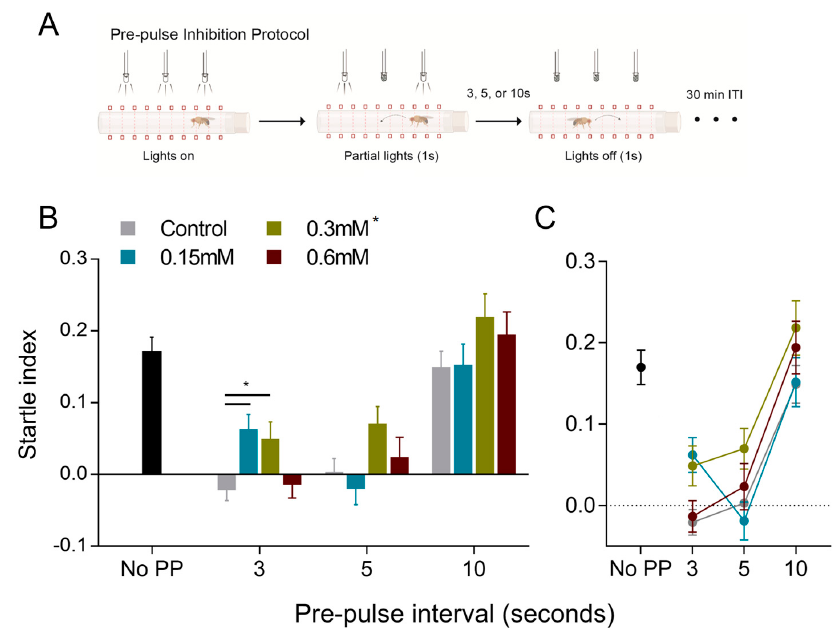
Figure 3. NMDA-dependent prepulse inhibition of motor response in flies. ( A ). The DISCO protocol was modified, so a dim-light prepulse was presented shortly before light-off stimuli. ( B ). Prepulse stimuli presented 3 s before were incapable of inhibiting the typical movement response. However, partial stimuli exhibition 3 and 5 s previous to the main stimuli were able to abolish the baseline response in controls, demonstrating prepulse inhibition (PPI). Considering all trials, MK-801 was able to have an effect on the movement of flies (average of 8 trials; two-way ANOVA, p MK-801 = 0.006; n = 38–81 flies/group), with clearer results at 0.3 mM concentration. Moreover, 0.15 mM and 0.3 mM MK-801 was able to significantly inhibit PPI within 3 s prepulse interval trials ( p = 0.007 and p = 0.023 for 0.15 and 0.3 mM, respectively, one-way ANOVA with Holm–Sidak posthoc test). ( C ). As expected, the length of the prepulse interval modulated the startle response, as the longer 10 sec interval was unable to produce PPI (two-way ANOVA, p trials < 0.0001). Moreover, no interaction effects between MK-801-exposure and were observed (two-way ANOVA, p interaction = 0.263). Values are shown as mean ± SEM. * p < 0.05.